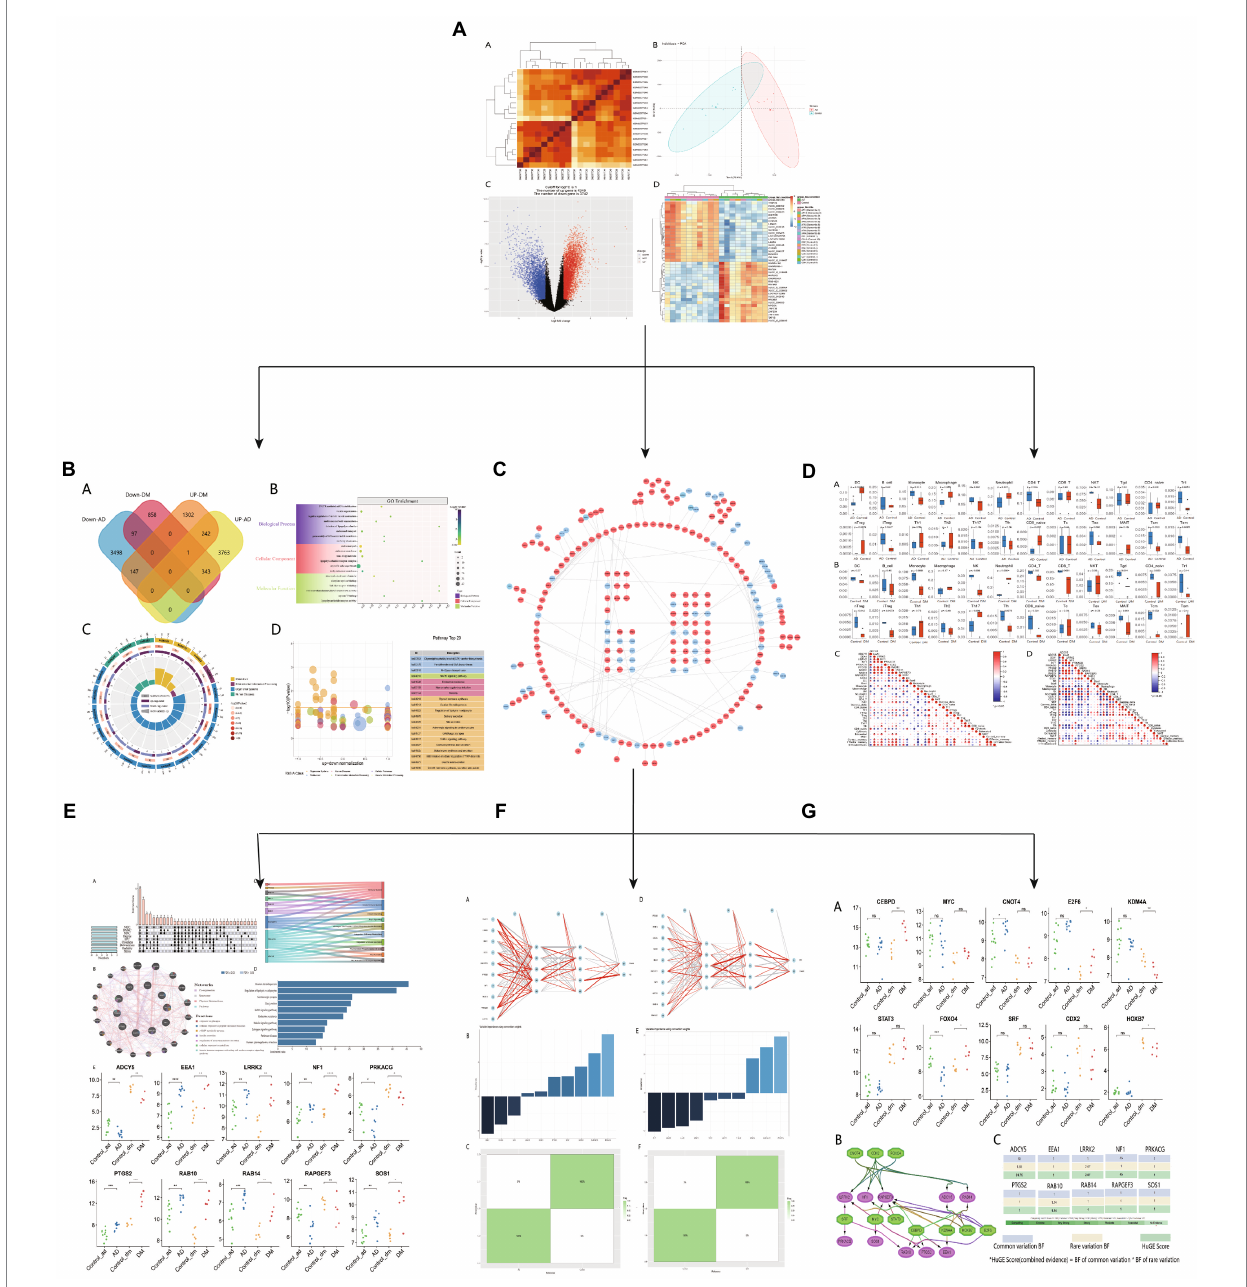
FIGURE 1 Research design flow chart. (A) Download AD and DM blood transcriptome data from GEO and analyze, (B) functional enrichment analysis of common differential genes, (C) PPI network map of common genes, (D) DM or AD immune infiltration analysis, (E) Hub gene expression level and co-expression network analysis, (F) Hub gene neural network analysis, (G) Hub gene TFs expression level and phenotypic correlation